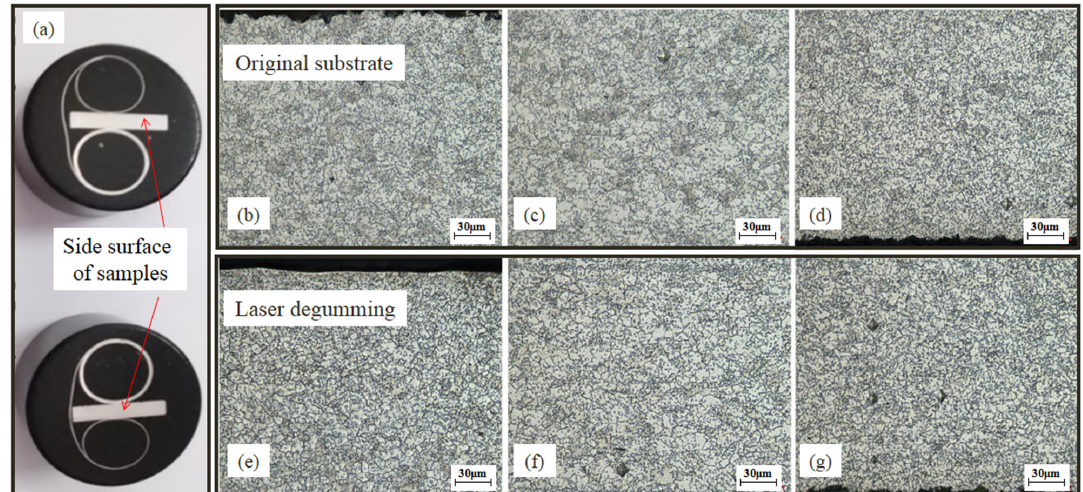
Figure 9. Sample preparation for metallographic examination ( a ) and micro-structures on the top surface of original substrate ( b ) and laser-degumming sample ( c ).